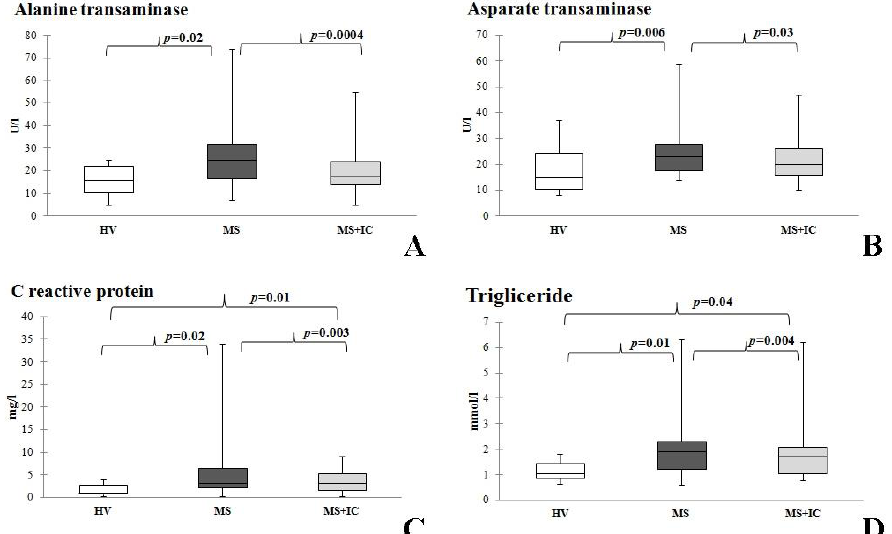
Figure 6. Biochemical parameters of blood serum before and after therapy. Alanine transaminase ( A ), Aspaparate transaminase ( B ), Creactive protein ( C ) and Trigliceride ( D ). Notes: HV — healthy volunteers; MS — patients with metabolic syndrome; MS + IC — patients with metabolic syndrome after consumption of indigenous consortium. Results are presented as median (25%; 75%).